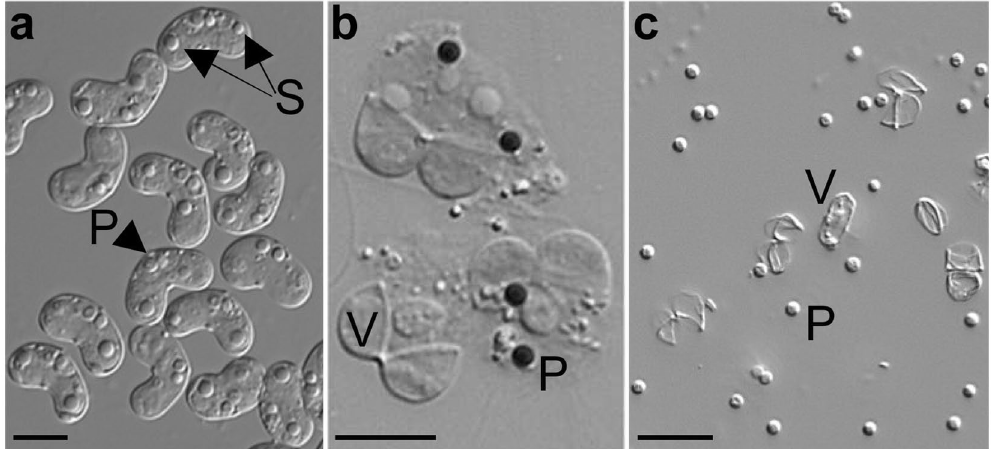
Figure 2. Isolation of polar capsules from whole myxospores. ( a ) Intact C. shasta myxospores with two polar capsules (P) and a binucleate sporoplasm (S). ( b ) Myxospores after valve cells (V) have been opened by SDS treatment, and polar capsules (P) stained dark with Toluidine blue. Note that polar capsules and valves are still held together with the spilled content of the spore. ( c ) Dissociated polar capsules and valves following enzymatic digestion. Scale bars = 5 μ m.